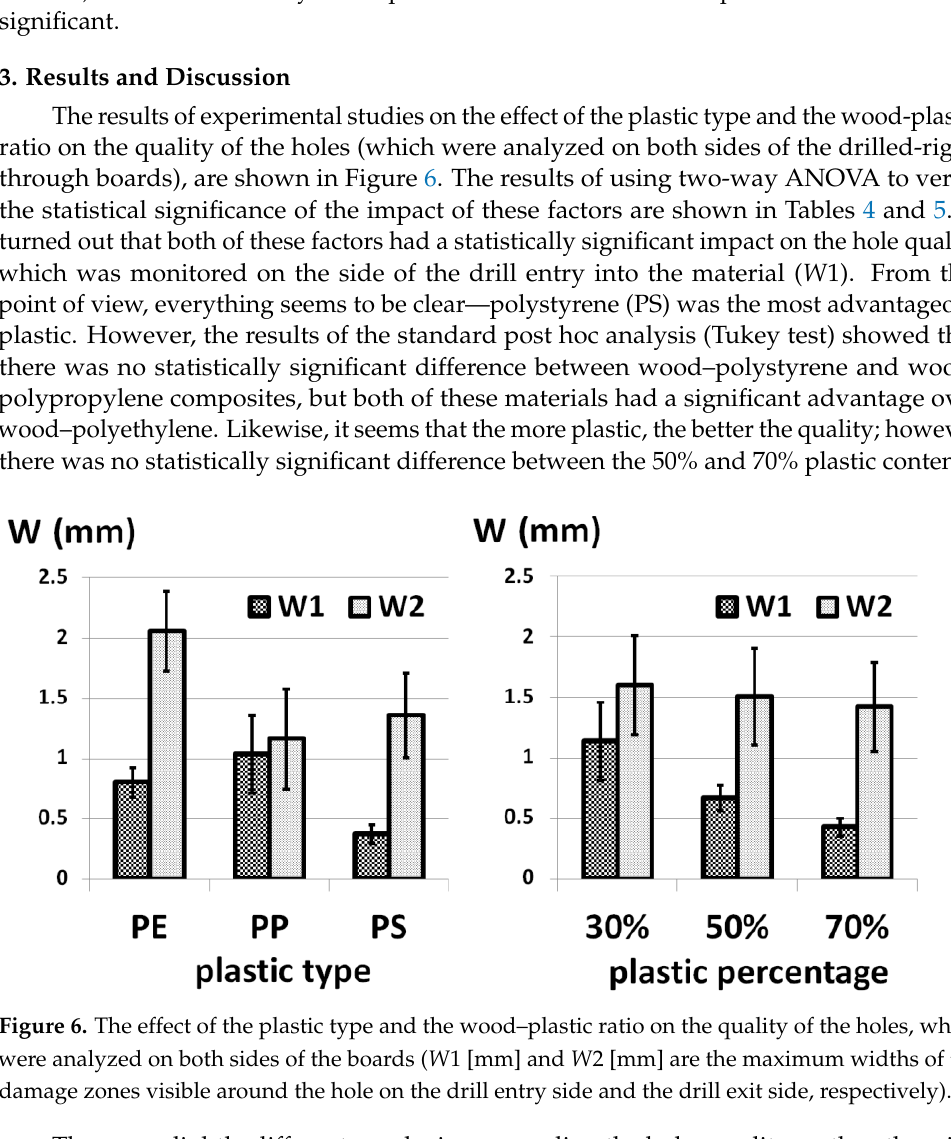
Table 5. The results of using ANOVA to verify the statistical significance of the impact of plastic type and plastic percentage on the maximum width of the damage zone on the drill exit side (W2